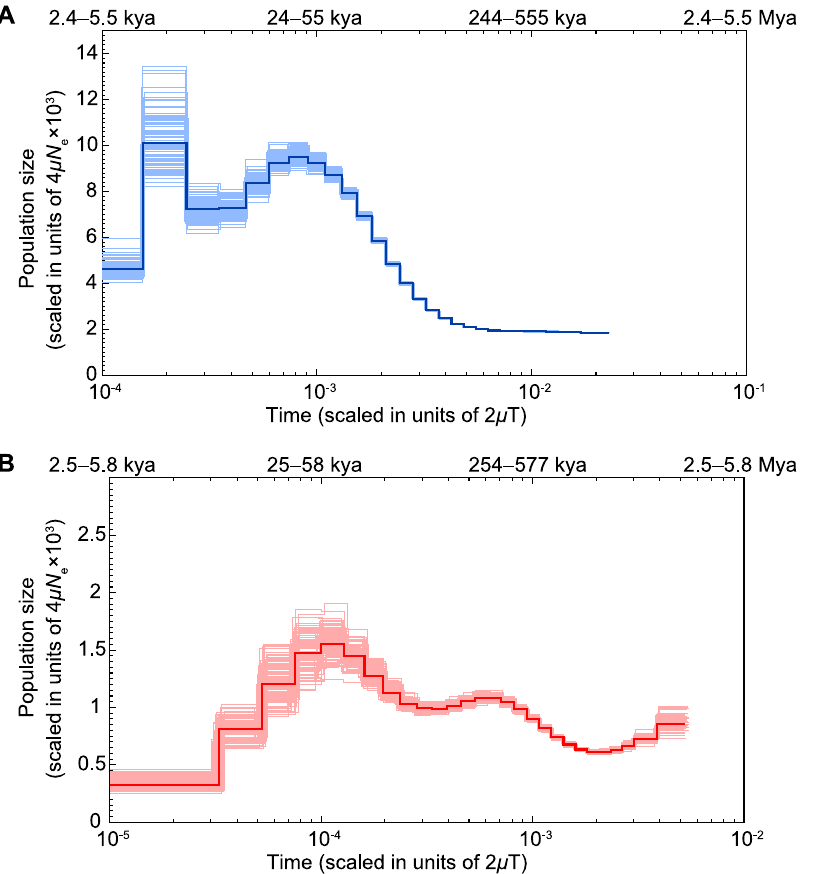
Figure 3. Comparative Demographic History Analysis and PSMC Effective Population Size Estimates for Bobwhite ( Colinus virginianus ) (A) and Scarlet Macaw ( Aramacao ) (B). Estimates of effective population size are presented on the y-axis as the scaled mutation rate. The bottom x-axis represents per-site pairwise sequence divergence and the top x-axis represents years before present, both on a log scale. Generation intervals of 1.22 years for the bobwhite ( Colinus virginianus ) and 12.7 years for the scarlet macaw ( Ara macao ) were used (See Methods). In the absence of known per-generation de novo mutation rates for the bobwhite and the scarlet macaw, we used the two human mutation rates ( m ) of 1.1 6 10 2 8 and 2.5 6 10 2 8 per generation [124,125] (see Methods). Darker lines represent the population size inference, and lighter, thinner lines represent 100 bootstraps to quantify uncertainty of the inference.